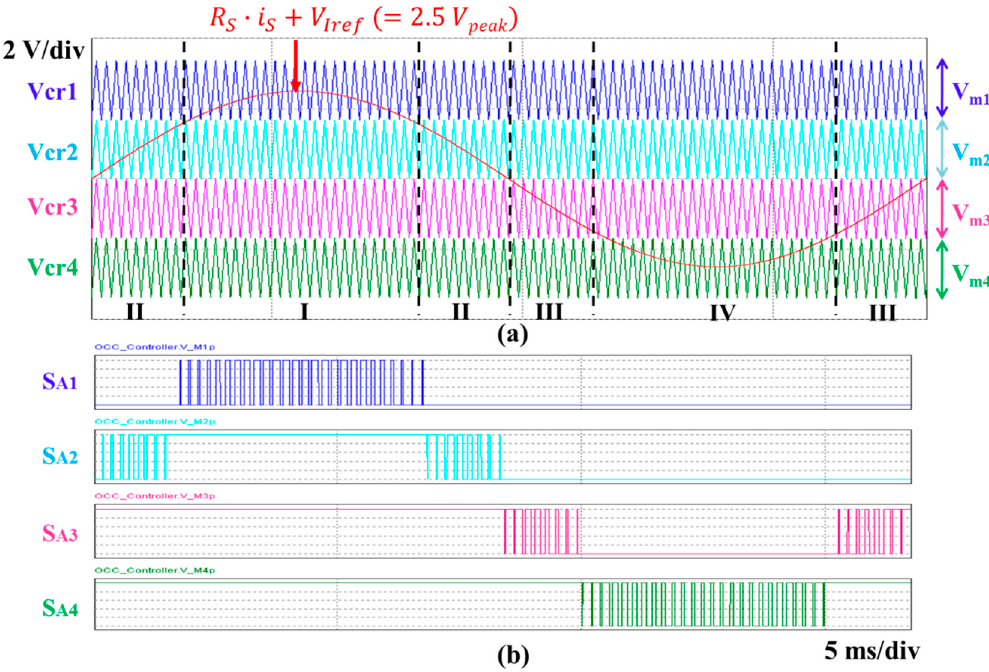
Figure 3. Single-phase five-level OCC MV Regen-Load PWM waveforms. ( a ) Control reference ( R S · I S + V Iref ) and four carrier signals; ( b ) Gate signals of four upper switches ( S A 1 – S A 4 ).